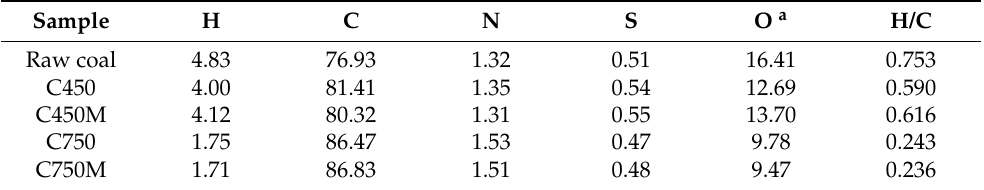
Table 2. Elemental analyses of studied samples (wt.%,